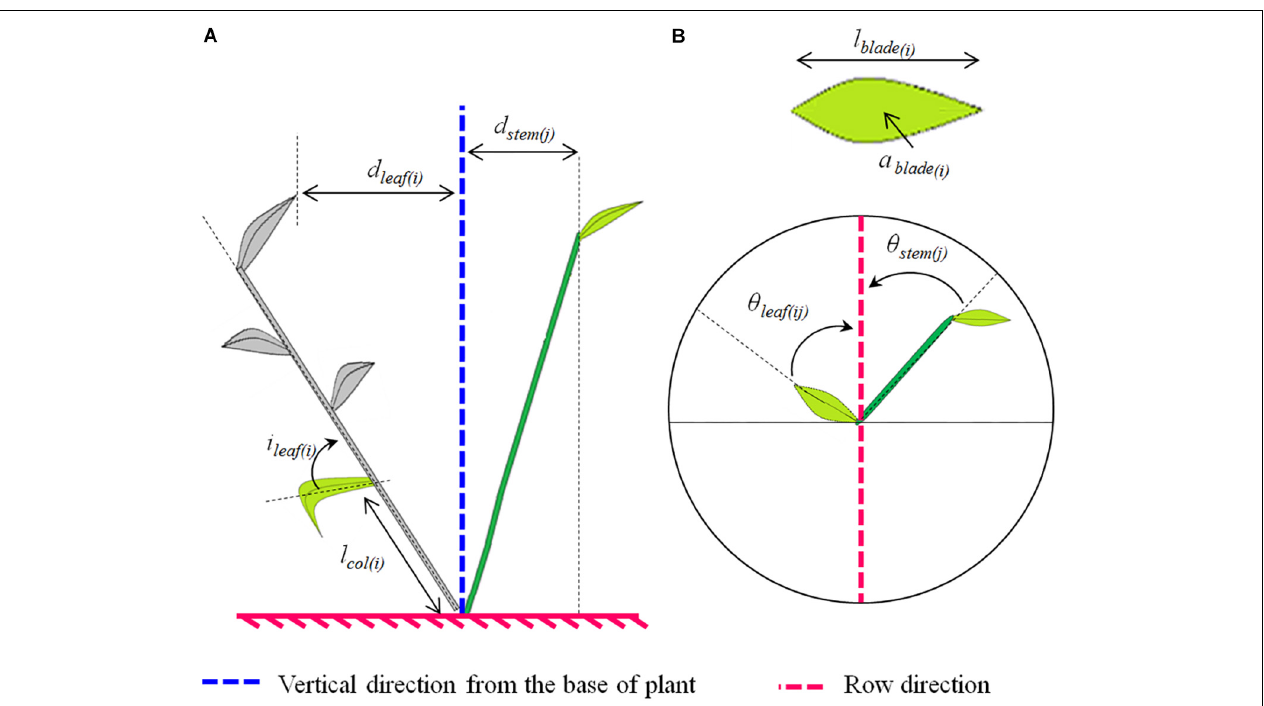
FIGURE 1 | Scheme illustrating the plant architectural traits analyzed ( A , side view; B , top view). The analyzed traits depended on the plant axis. For both main stems and tillers we analyzed: (i) the horizontal spread of the axis “ j ,” which represents the horizontal distance between the higher leaf collar on the axis and the plant base ( d stem ( j ) ); (ii) the horizontal spread of the leaf rank at rank “ i ” on the axis “ j ,” which represents the horizontal distance between the tip of the leaf and the plant base ( d leaf ( ij ) ); (iii) the azimuth angle of the leaf at rank “ i ” on the axis “ j ” which represents the angle between the projection of the midrib on the horizontal plane and the row direction ( θ leaf ( ij ) ); and (iv) the azimuth angle of the stem or pseudo-stem of the axis “ j ,” which represents the angle between the projection of the stem or pseudo-stem on the horizontal plane and the row direction ( θ stem ( j ) ). Additionally, the following traits were analyzed for the main stems only: (i) the final blade length of the leaf at rank “ i ”( l blade ( i ) ); (ii) the mature blade area of the leaf at rank “ i ” ( a blade ( i ) ); (iii) the length between the collar of the leaf at rank “ i ” and the plant base ( l col ( i ) ); and (vi) the angle of insertion of the leaf at rank “ i ,” which represents the basal angle between the blade midrib and the bearing axis ( i leaf ( i )